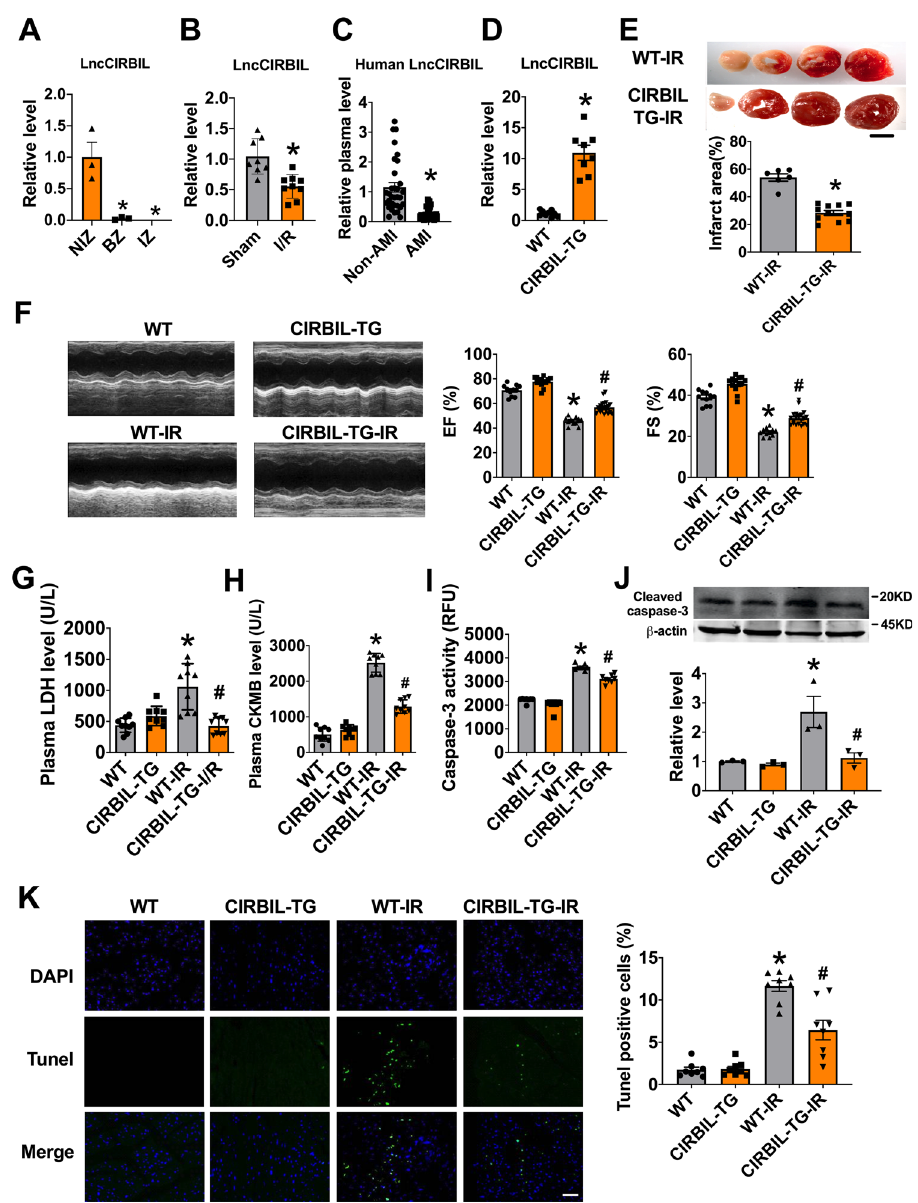
Fig. 1 Cardiomyocyte-speci fi c transgenic overexpression of lncCIRBIL alleviates cardiac ischemia – reperfusion injury. A The levels of lncCIRBIL in ischemia zone (IZ), border zone (BZ), and non-ischemic zone (NIZ) of ischemia – reperfusion hearts. N = 3. * P < 0.05 versus NIZ. P values were determined by one-way ANOVA test followed by Bonferroni post hoc analysis. B The level of lncCIRBIL in ischemia – reperfusion (I/R) and sham-operated hearts. Sham N = 8, I/R N = 9. * P < 0.05 versus Sham. P values were determined by unpaired t test. C Level of human lncCIRBIL in the plasma of acute myocardial infarction (AMI) patients. N = 32. * P < 0.05 versus non-AMI group. P values were determined by unpaired t test. D Level of lncCIRBIL in the heart of lncCIRBIL transgenic mice. WT N = 9, CIRBIL-TG N = 8. * P < 0.05 versus WT group. P values were determined by unpaired t test. E Infarct size of I/R hearts by TTC staining (scale bar: 2 mm). WT-I/R N = 6, CIRBIL-TG-I/R N = 11. * P < 0.05 versus WT-IR mice. P values were determined by unpaired t test. F Representative images of echocardiographs and statistics of ejection fraction (EF) and fractional shortening (FS). WT N = 11, CIRBIL-TG N = 13, WT-I/R N = 11, CIRBIL-TG-I/R N = 21. * P < 0.05 versus WT, # P < 0.05 versus WT-IR. P values were determined by one-way ANOVA test followed by Bonferroni post hoc analysis. G , H Plasma levels of LDH and CKMB, respectively. N = 9 mice per group. * P < 0.05 versus WT, # P < 0.05 versus WT-IR. P values were determined by one-way ANOVA test followed by Bonferroni post hoc analysis. I Caspase-3 activity. N = 8 mice per group. * P < 0.05 versus WT, # P < 0.05 versus WT-IR. P values were determined by one-way ANOVA test followed by Bonferroni post hoc analysis. J Cleaved caspase-3 protein level. N = 3 mice per group. * P < 0.05 versus WT, # P < 0.05 versus WT-IR. P values were determined by one-way ANOVA test followed by Bonferroni post hoc analysis. K Apoptosis of cardiomyocyte in the border zone (BZ) determined by TUNEL staining (scale bar: 20 μ m). N = 8 mice per group. * P < 0.05 versus WT, # P < 0.05 versus WT-IR. P values were determined by one-way ANOVA test followed by Bonferroni post hoc analysis. Data are expressed as mean ± SEM. WT wild type, WT-IR wild type with ischemia – reperfusion, CIRBIL-TG CIRBIL transgenic overexpression, CIRBIL-TG-IR CIRBIL transgenic overexpression mice with ischemia – reperfusion.